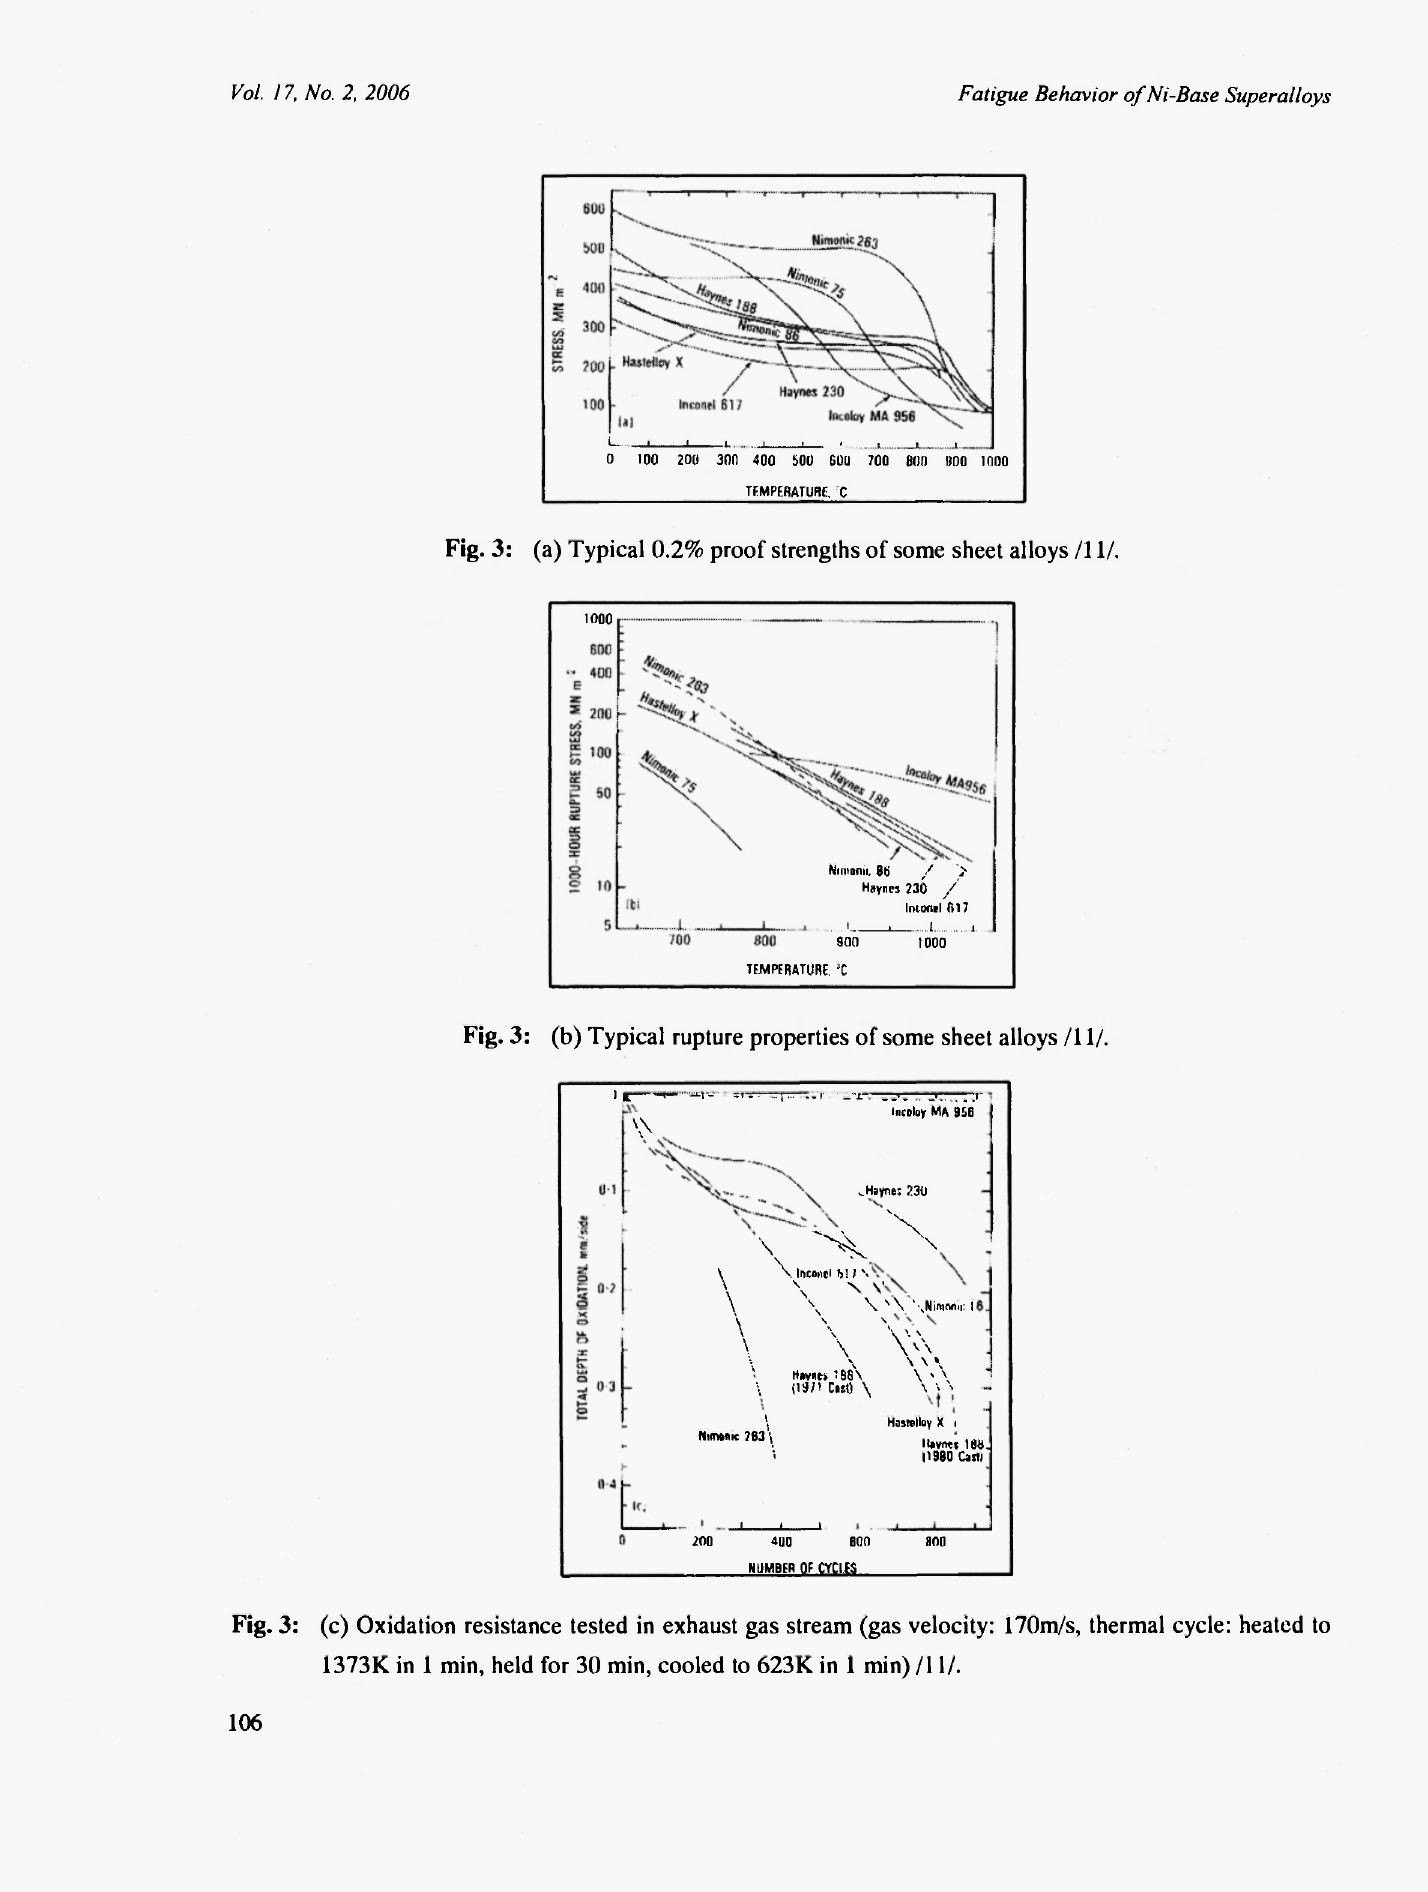
(a) Typical 0.2% proof strengths of some sheet alloys /11/.